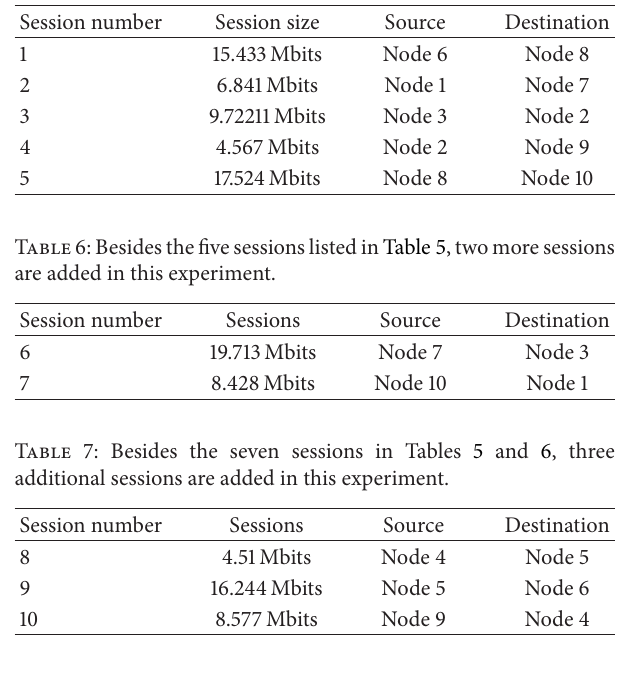
Table 5: Size, source, and destination nodes of five sessions.